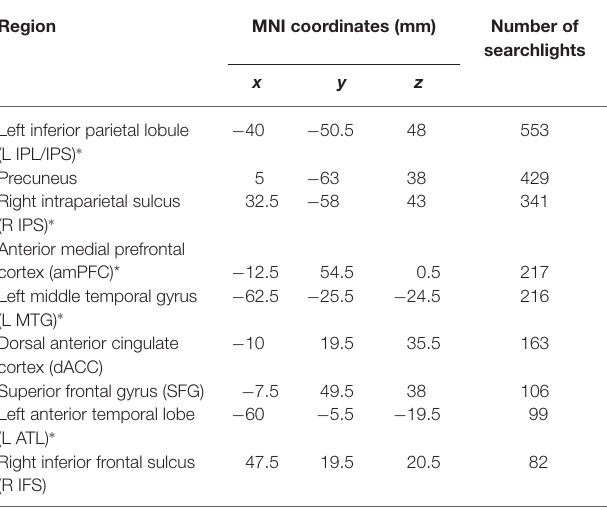
TABLE 1 | Coordinates of peak accuracy in each searchlight